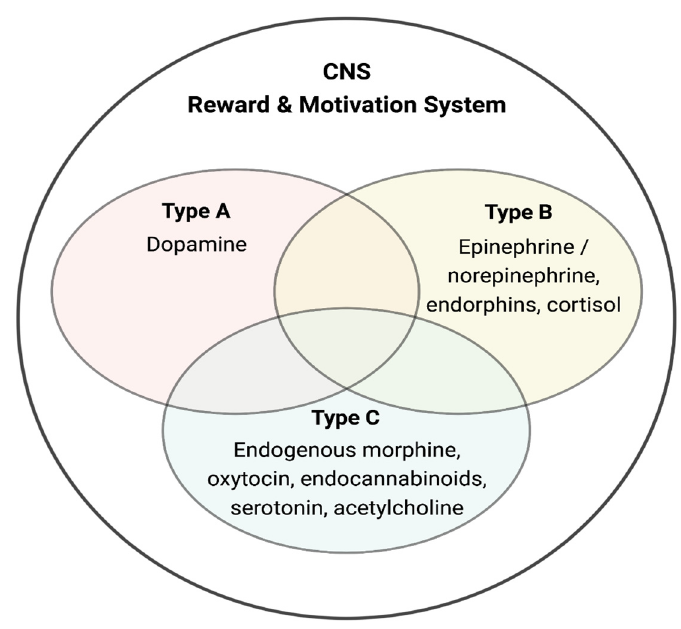
Figure 2. Type A–C motivation systems. These subsystems (A  appetitive motivation; B  stress/threat avoidance; C  relaxation/quiescence) share a common process (enzymatic-neurobio- logical cascade)—mechanisms that converge on the CNS motivational and reward system that in- cludes critical neurotransmitters and distinctive regions (i.e., specific reward messengers, among others; references: see text and